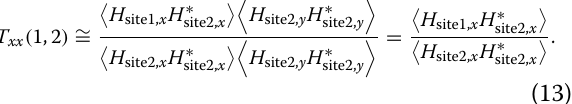
all geomagnetic events are homogeneous and have the same spatial gradients between two sites; case B: all geo- magnetic events have different spatial gradients at site 1, but the same spatial gradients at site 2; case C: all geo- magnetic events have different spatial gradients between the two sites (event 0 causes variations near site 2 and event 1 causes variations near site 1); and case D: all geo- magnetic events produce different spatial gradients between the two sites.